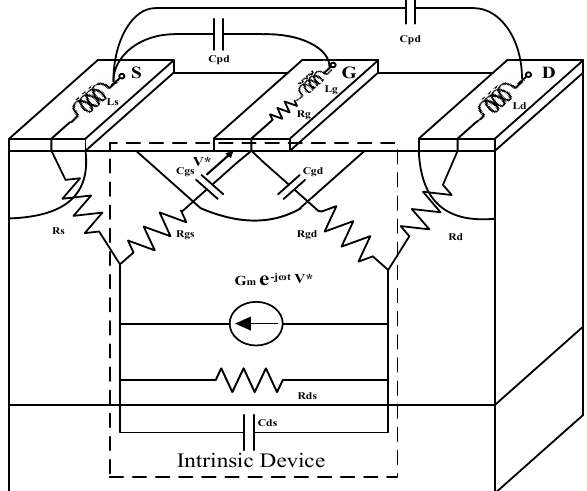
Figure 3. Structure of GaN HEMT with parasitic elements (adapted from [28]).